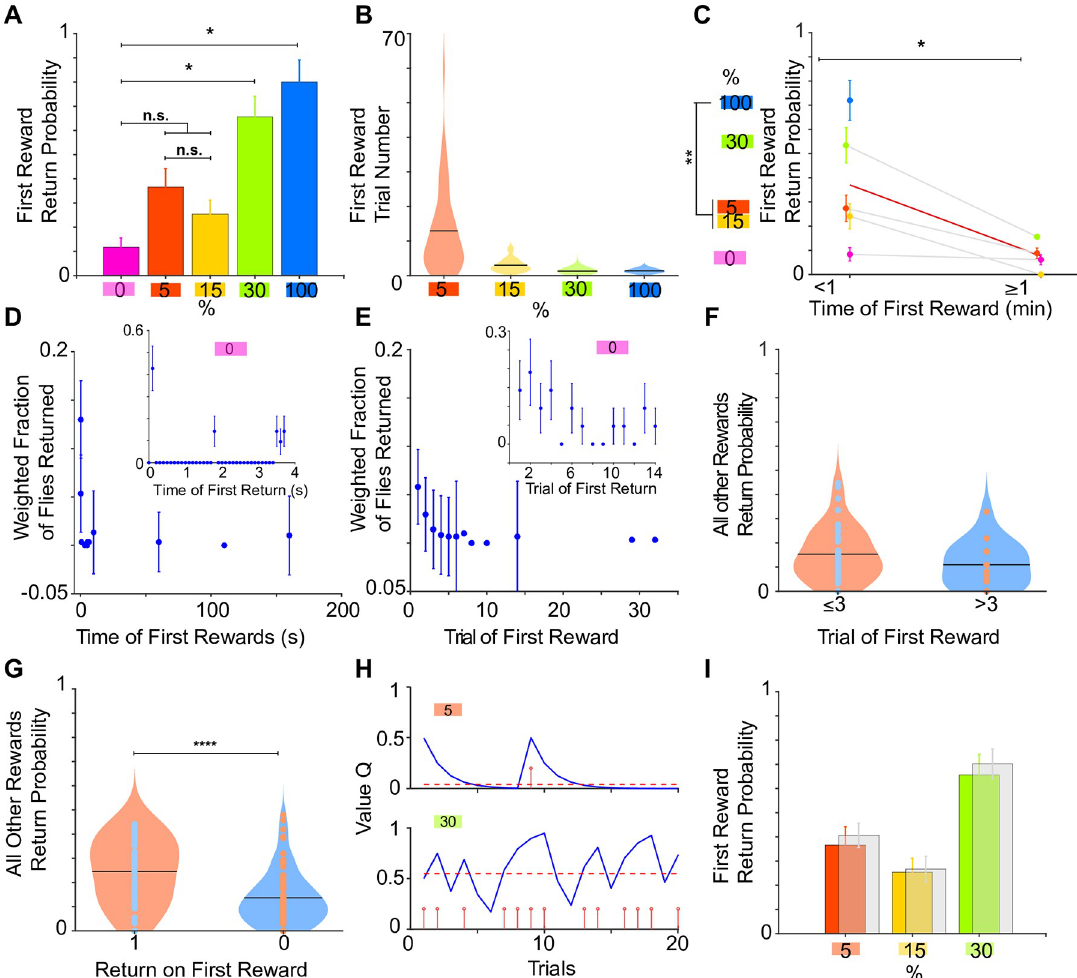
Fig 4. The timing of first rewards affect return frequency. A Return behavior upon first reward per probability condition. For unstimulated controls (0%, magenta) the return probability was computed for the first trial. ( � : p < 0.05; pairwise Fishers exact test.) B First rewarded trial number per probability condition. Black lines: mean. C Return behavior upon first reward within the first minute of recording and after the first minute. Blue circles without a connecting grey line correspond to conditions where the first reward always happened within the first minute. Red line: average return probability. Magenta circles and dark grey line: unstimulated controls. Error bars: ± SEM. ( � : p < 0.05; �� : p < 0.01; ��� : p < 0.001, Kruskal-Wallis test with multiple comparisons and Welch’s t-test). D Fraction of flies (independent of stimulation probability) that returned to a first reward within the first 200s (time bins: 0.03s between 0 and 1s, 0.1s between 1 and 9s, 50s from 10 to 200s and 100s from 300 to 1000s). Inset: Fraction of unstimulated flies that returned for the first time since the session start against time (time bins of 0.1s). Error bars: ± SEM. E Fraction of flies that returned to a first reward within in the first 30 trials. Inset: Fraction of unstimulated flies that returned for the first time against the trial index. Error bars: ± SEM. F Return probability to all other rewarded trials when the first reward happened within the first 3 trials (orange violin) or after the first 3 trials (blue violin). G Return probability to all other rewarded trials depending on whether the fly returned upon the first reward (orange violin) or not (blue violin). ( ��� : p < 0.001, Welch’s t-test) H Two examples for the evolution of the RL value Q (blue curve) over trials. Upper figure: 5% stimulated fly. Lower figure: 30% stimulated fly. Red stems: stimulation events. Red dashed line: average value. I Transparent grey bars: RL model’s prediction of first reward return rate. (Color bars as in A ).